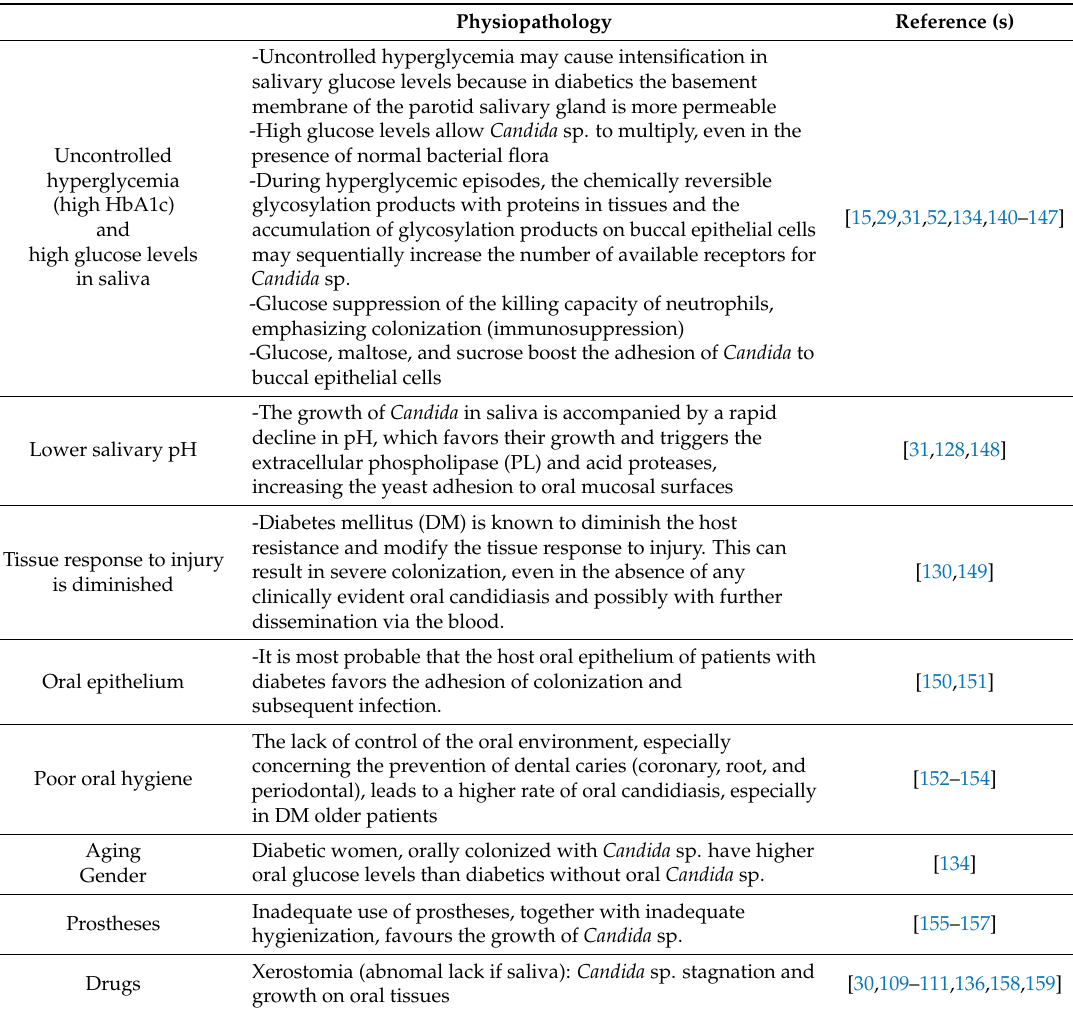
Table 1. Physiopathology and etiology related to the occurrence of oral candidiasis in